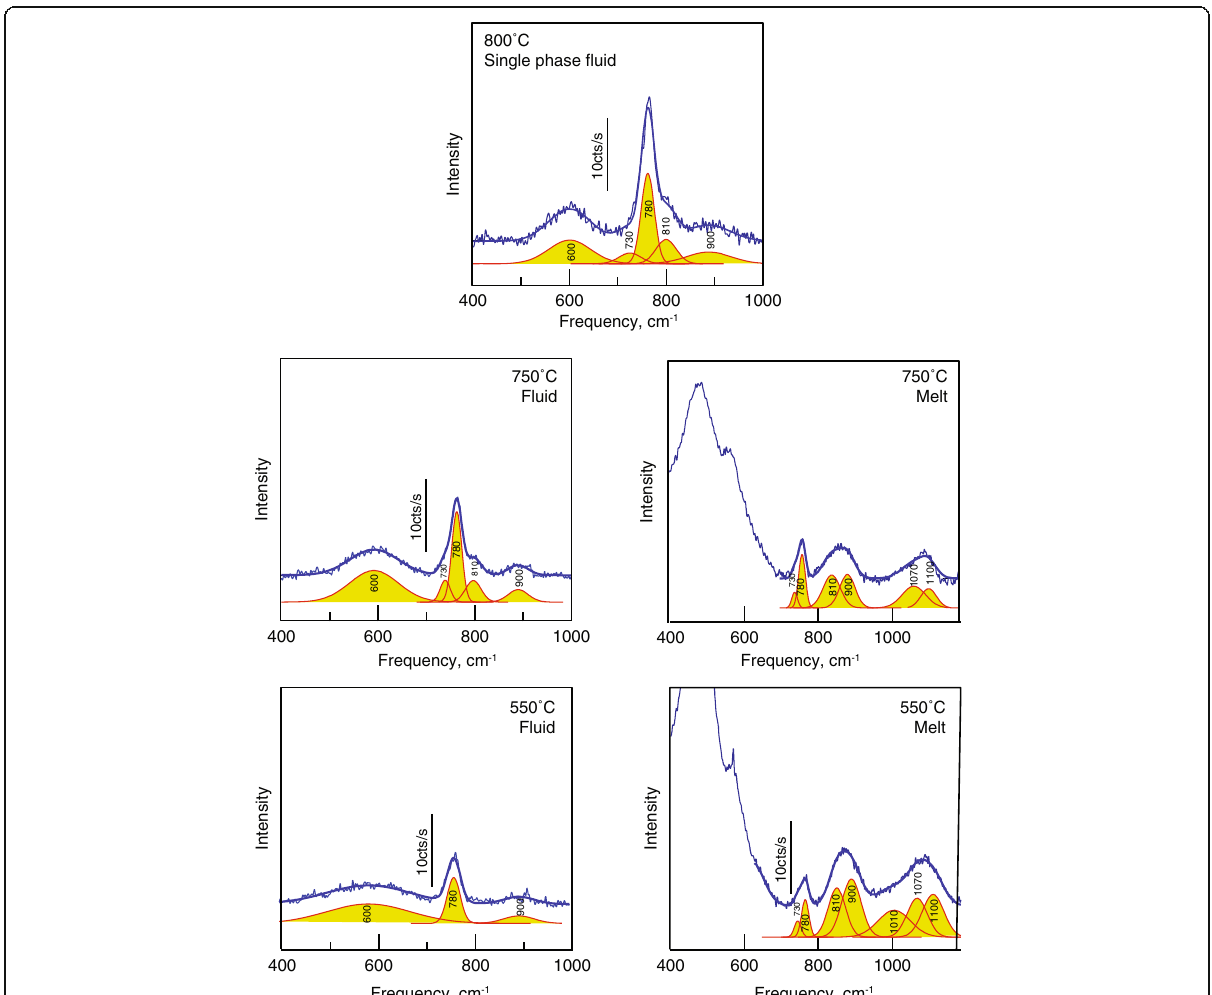
Fig. 10 Examples of Raman spectra of single phase fluid (at 800 °C) and coexisting fluids and melts at temperatures indicated (corresponding pressures in Table 1). Also shown in the spectra are fitted Gaussian lines relevant to structural assignments of silicate and carbonate species. The intensity scale in each spectrum is